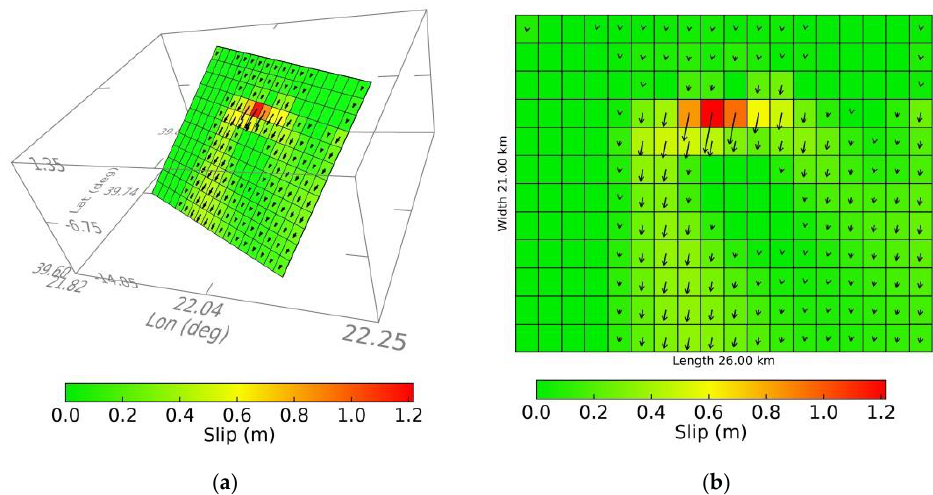
Figure 14. Modelled geodetic seismic fault for the earthquake of 4 March 2021 in ( a ) 3D illustration and ( b ) vertical profile along strike (ESE–WNW).